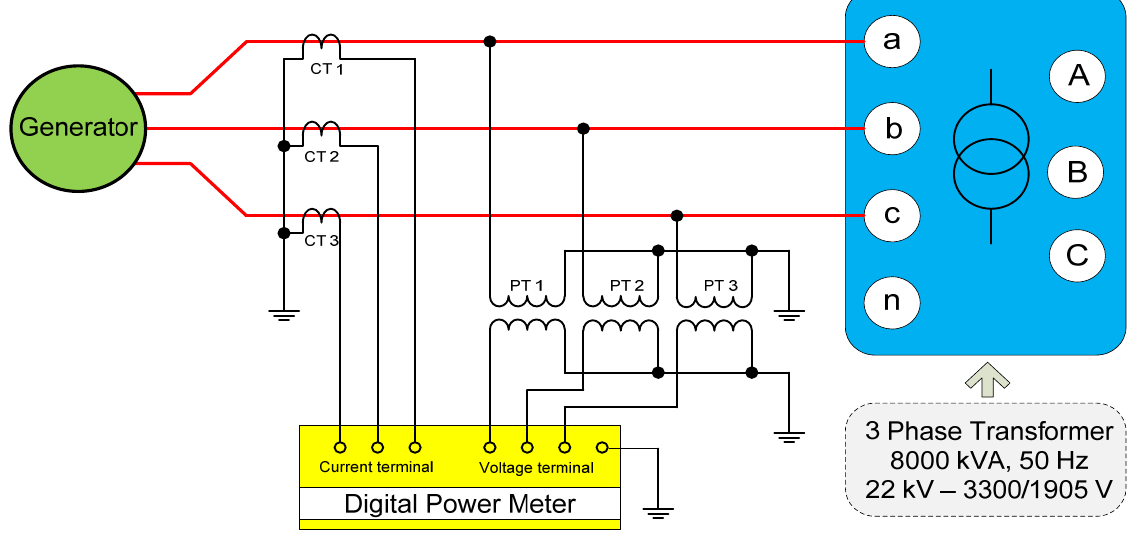
Figure 10. The test circuit of over-induced voltage.